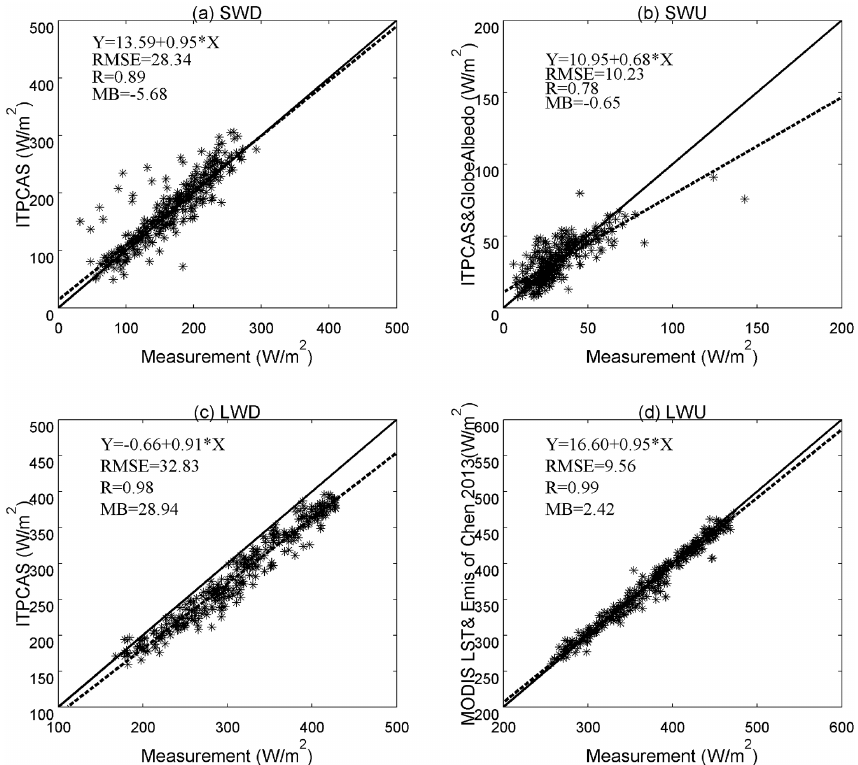
Figure 4. Scatter point for downward short-wave (SWD), upward short-wave (SWU), downward long-wave (LWD), and upward long-wave (LWU) radiation against in situ measurement.